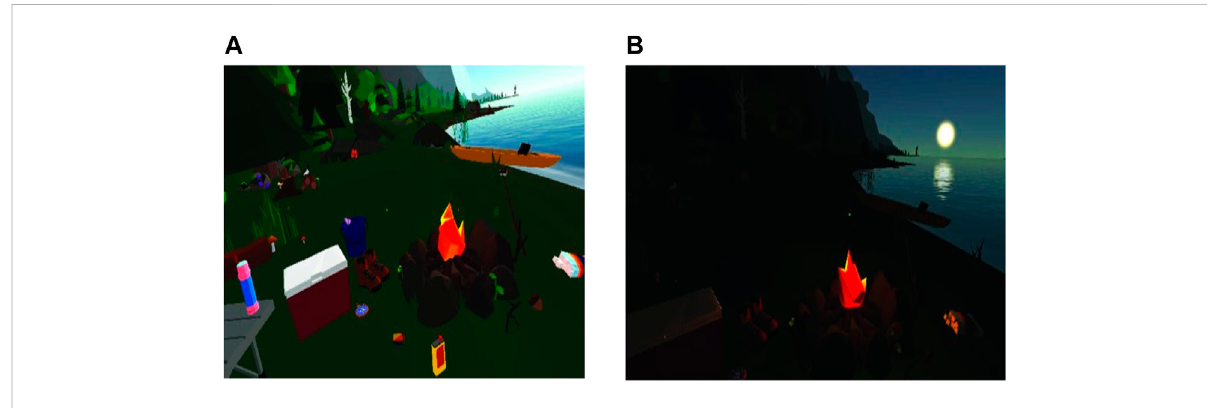
FIGURE 1 ScreenshotsoftheHappyPlaceapplication (A) Dayenvironmentwithinteractiveobjects. (B) Nightenvironment(reproducedfromLindneretal. (2019)).